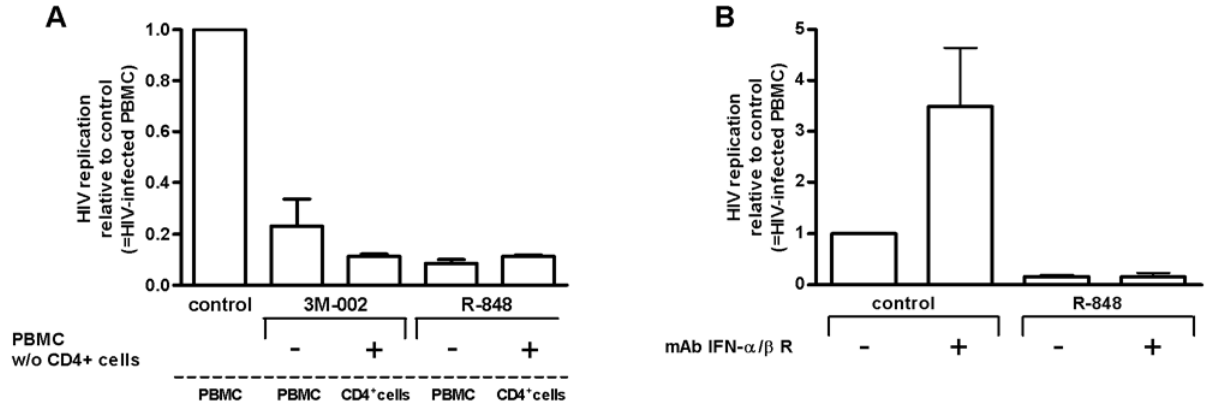
Figure 5. Soluble factors are critical to the anti-HIV effects after triggering TLR8 and 7/8. (A) Isolated CD4 + T-cells of PBMC were infected with HIV overnight. Transwells were added with the purpose to separate the HIV infected CD4 + T-cells by a semi-permeable membrane (indicated by the dashed line) from autologous uninfected PBMC devoid of CD4 + T-cells. TLR agonists were added to the culture medium as indicated in the figure. Infected PBMC where the TLR agonists were added to the insert served as positive control for the TLRs’ efficient antiviral activity. Notably, CD4 + T- cells do not express TLR7 and 8 and thus do not react to the TLR agonists added. In this setup any inhibitory HIV activity observed when HIV infected CD4 + T-cells were separated by a semi-permeable membrane from the PBMC (devoid of CD4 + T-cells) must be due to factors secreted by the PBMC into the medium, which then diffuse through the semi-permeable membrane (n=3). This setup with separated cells was compared to PBMC which have been treated identically. Control indicates PBMC infected with HIV. B) Blocking the IFN- a / b receptor (IFN- a / b R) does not reverse the TLR7/8 triggering mediated inhibition of HIV. Neutralizing antibodies to IFN- a / b R was added at 10 m g/ml 30 minutes prior to R-848 to PBMC which was infected two days later with HIV. All values were indicated as relative to the matched control which was arbitrarily set to 1.